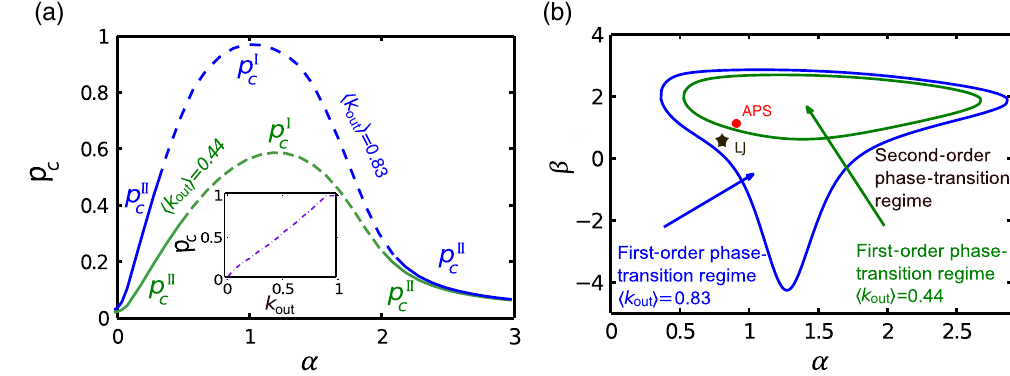
FIG. 4. The phase diagram predicted by the influence-percolation model with correlation. (a) Prediction of the percolation threshold versus α according to Eqs. (9) and (12) for ð β ; γ Þ ¼ ð 1 . 04 ; 2 . 90 Þ and h k , as indicated. Solid lines denote the region in α of second- out i order transitions, while dashed lines denote first-order transitions. The inset shows the increase of p II c with h k for ð α ; β ; γ Þ ¼ out i ð 0 . 91 ; 1 . 04 ; 2 . 90 Þ . (b) Phase diagram denoting the areas in the plane ð α ; β Þ of first-order and second-order regimes for two values of h k out i , as indicated. The first-order regime is inside the indicated curve, while the second order is outside for a given value of h k out i . The location of the APS networks in the phase diagram is indicated as a red dot. The networks are located near the boundary of the 0 . 44 and inside the region of first order for h k 0 . 83 . The LJ network is also located in the first-order- transitions for h k out i ¼ out i ¼ transition